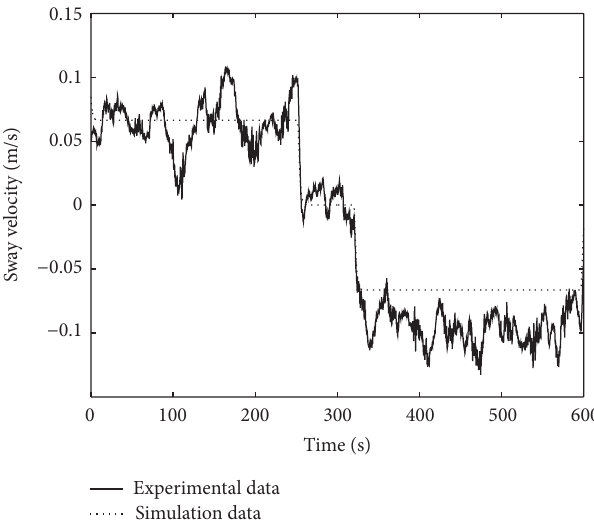
Figure 7: Sway velocity obtained in two consecutive turning manoeuvres with the ship (solid line) and in simulation (dotted line).